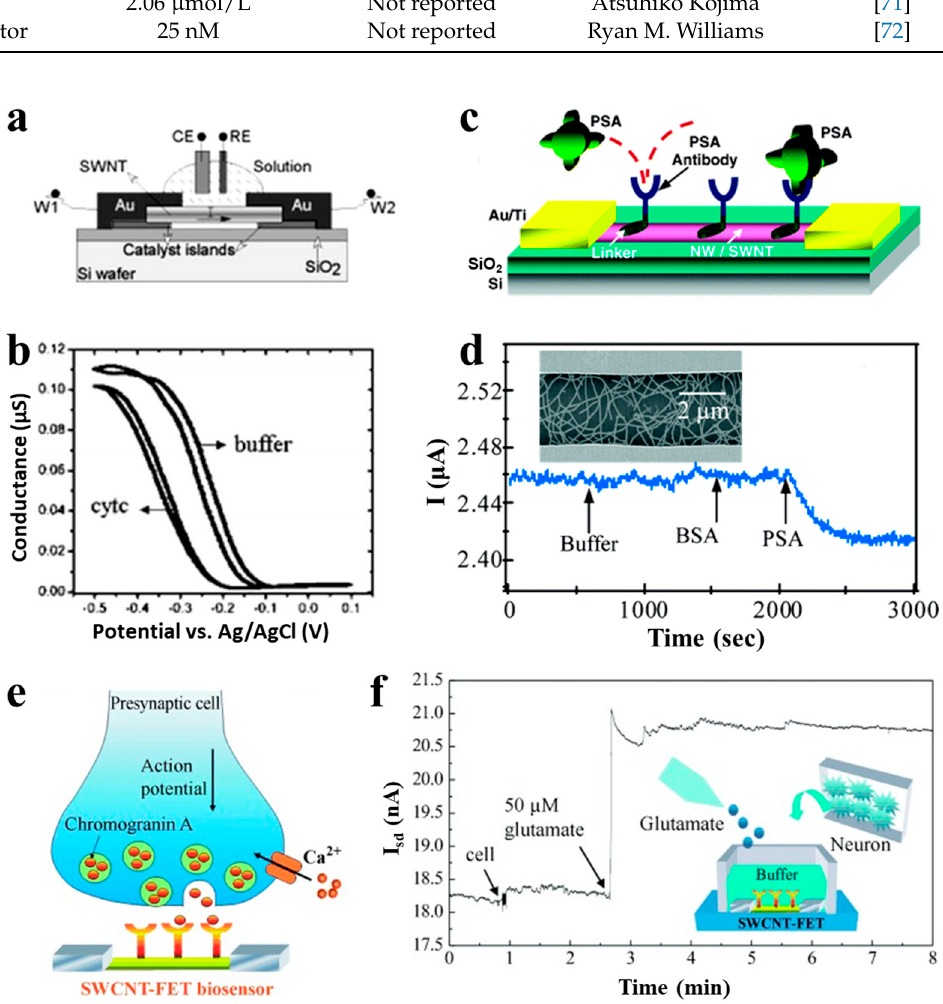
Figure 5. CNTFET-based sensors for protein detection. ( a ) Schematic illustration of a SWCNT device for cytochrome c detection [61]. ( b ) Conductance of the CNTFET as a function of the electrochemical potential in phosphate buffer and 200 µM cytochrome c in buffer. ( c ) Schematic device diagram and ( d ) current change of CNT nanosensors for prostate-specific antigen (PSA) detection [62]. ( e ) Schematic illustration of chromogranin (CgA) released from neurons and ( f ) its detection by monitoring the current change of a CgA antibody-modified CNTFET [63].